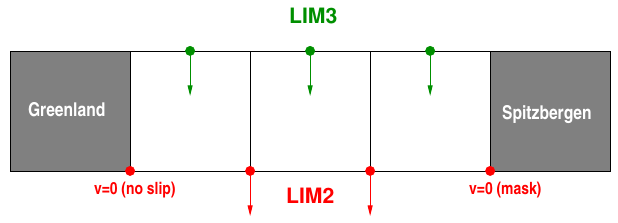
Fig. 7. Models representations of the meridional sea ice velocities at Fram Strait on a B-grid (LIM2, red) and a C-grid (LIM3, green). Note that Fram Strait is actually 9 grid cells wide, but we show here a schematic representation for